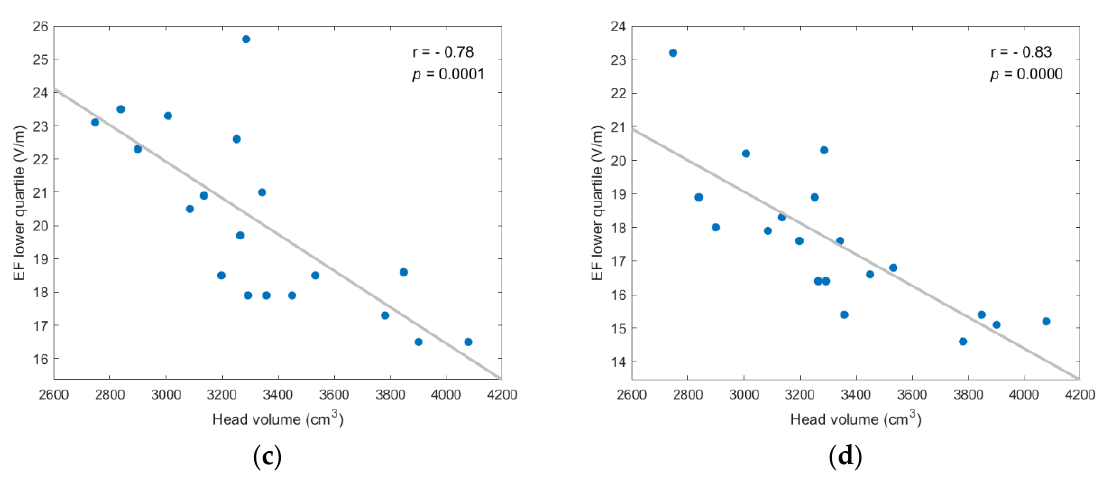
Figure A5. EF lower quartile showed strong, and statistically significant negative, correlation to head volume for every coil position/model version scenario; ( a ) frontal coil position on anatomical models; ( b ) frontal coil position on homogeneous models; ( c ) central coil position on anatomical models; ( d ) central coil position on homogeneous models.